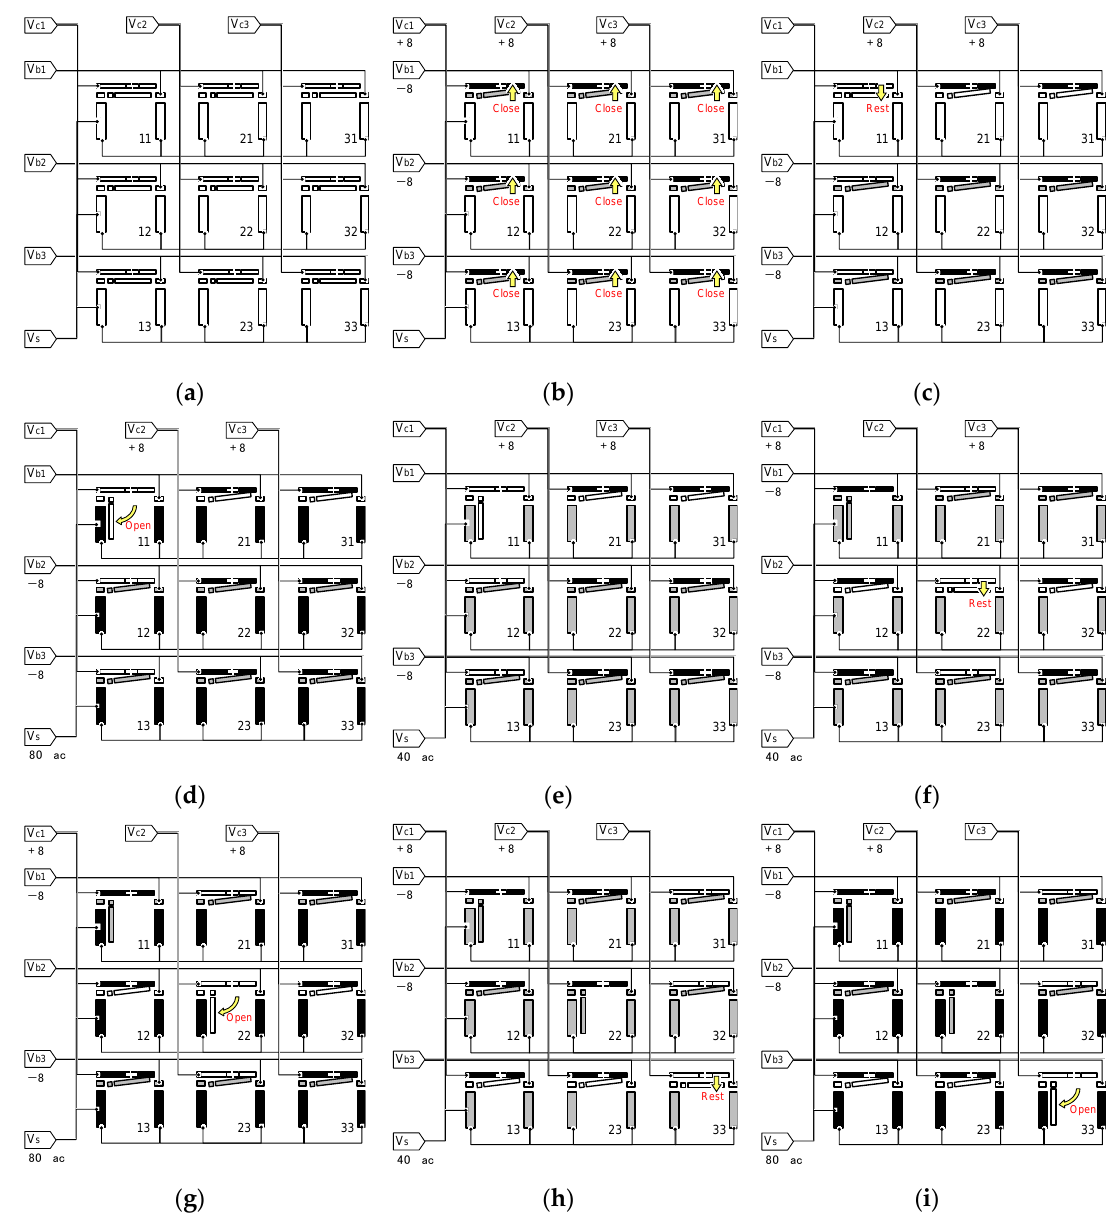
Figure 9. Operation sequence to open an arbitrary one of the shutter elements. Side views of the shutter, the cover plate, and the substrate are shown. ( a ) Initial state, ( b ) all closed, ( c ) element-11 released, ( d ) element-11 opened, ( e ) hold, ( f ) elemnt-22 released, ( g ) element-22 opened, ( h ) element-33 released, and ( i ) element-33 opened.